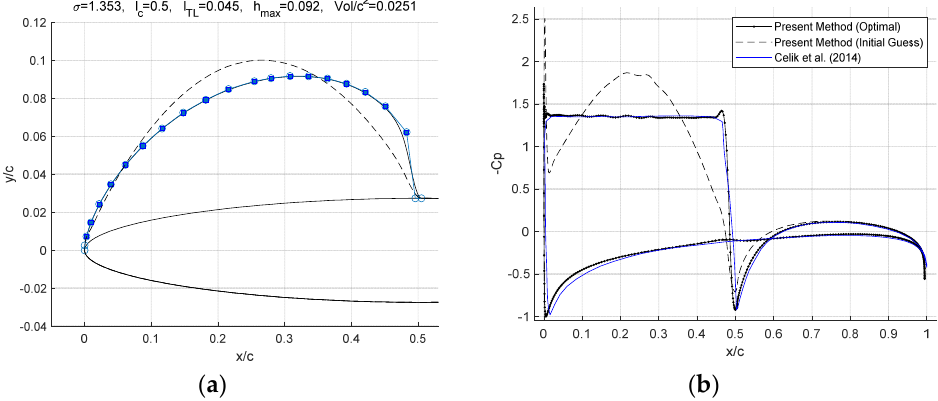
Figure 8. Comparison between the present method for the results found in the work of [18]. ( a ) Initial (h2) and final cavity shape for NACA16–006 with lc = 0.5 at a = 6 ◦ . The squares represent the control points of the B-spline representation. ( b ) Pressure coefficient.